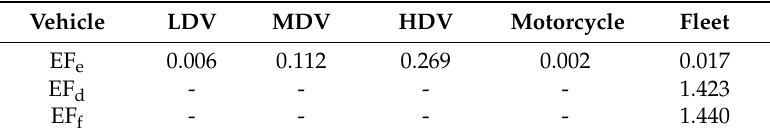
Table 3. Emission factors calculated by emission models (g/km).